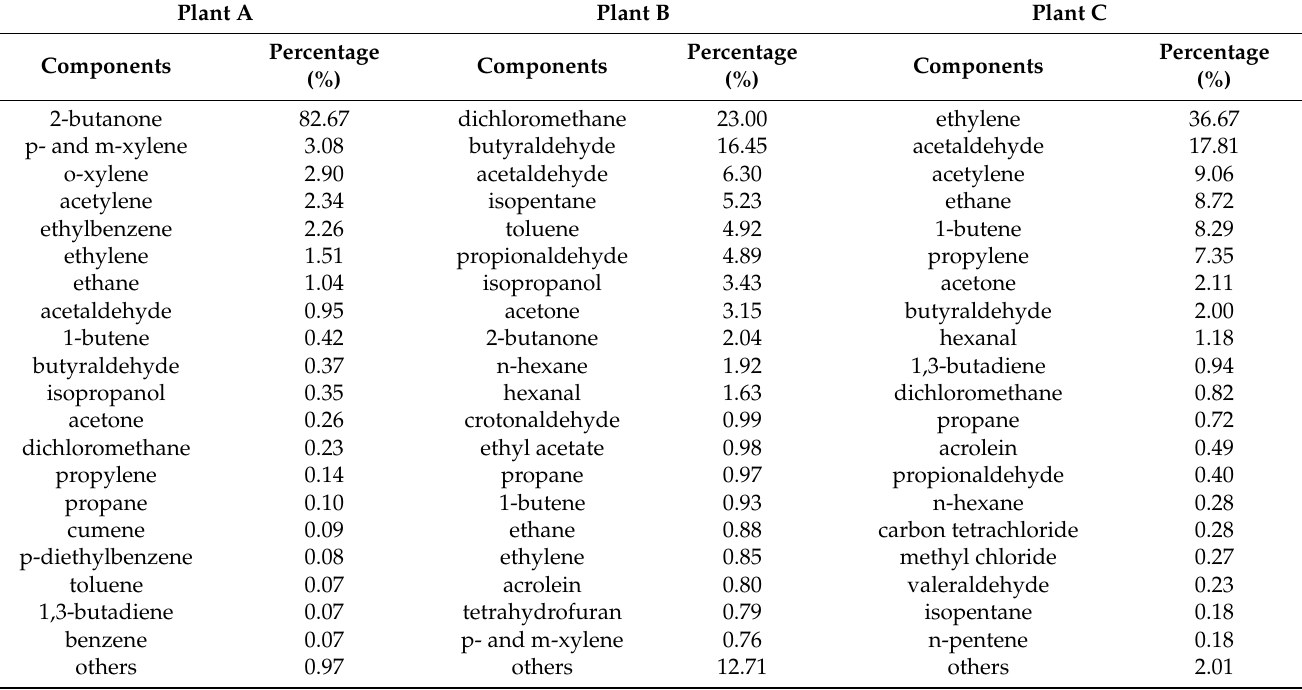
Table 2. Profiles of specific VOCs components in the three plants.